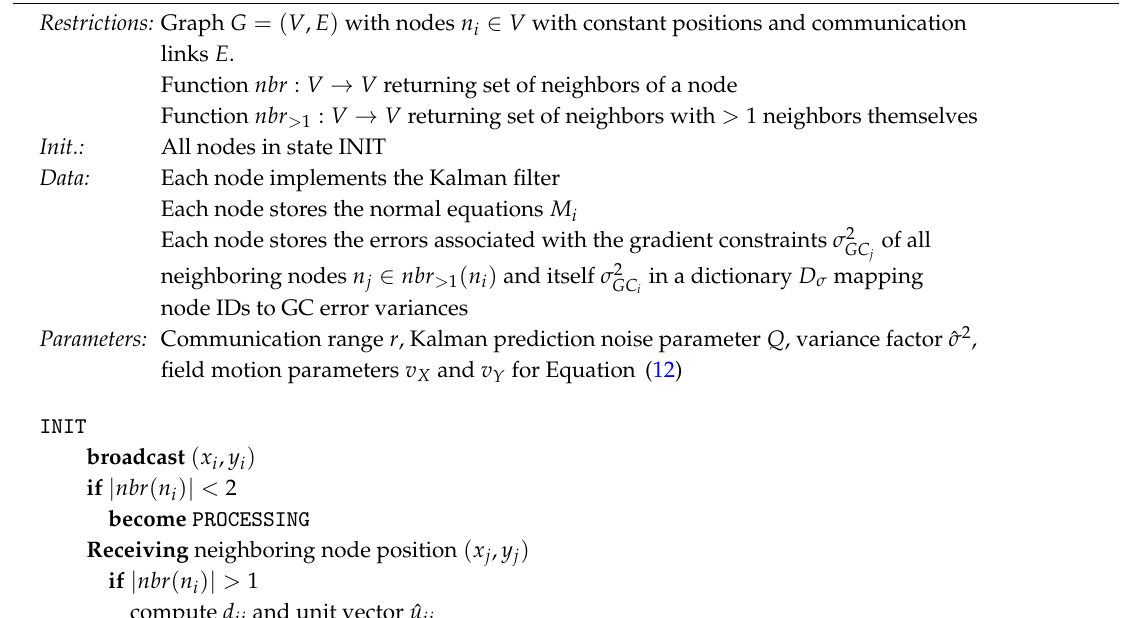
Protocol 1: Field motion estimation with a node n